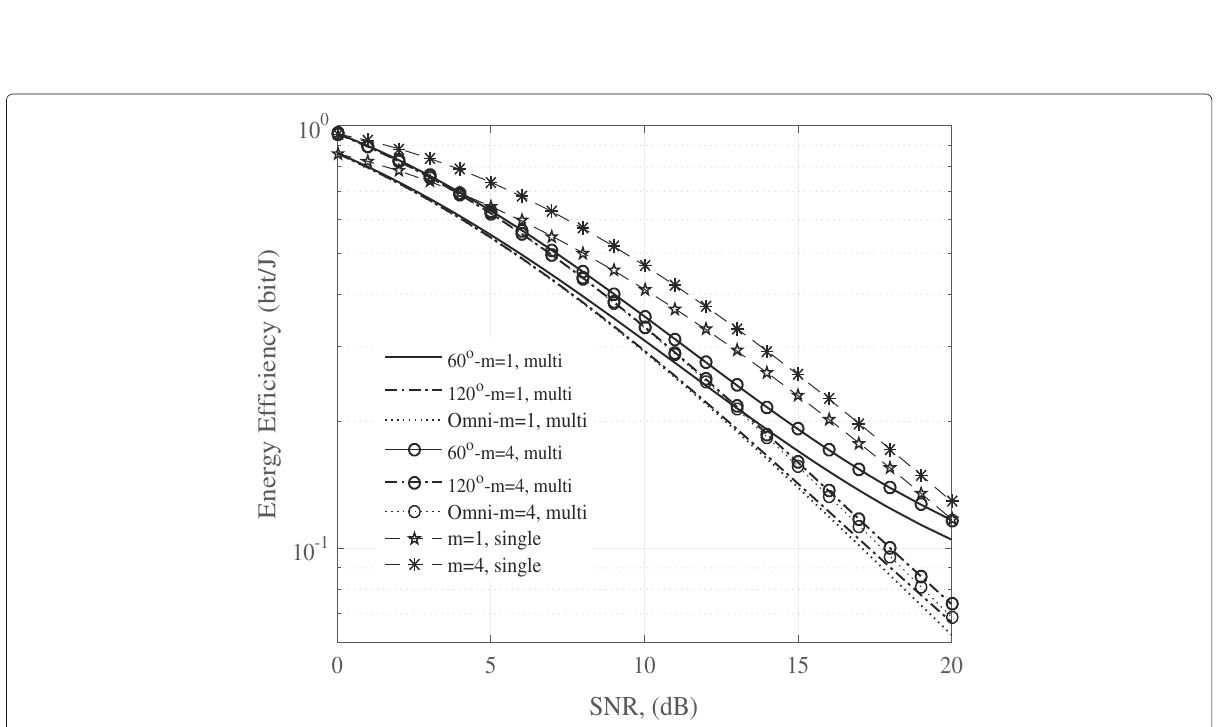
Fig. 5 Energy efficiency in (bit/J) for single- and multi-cell cellular networks for three different antenna configurations as a function of SNR for various values of fading figure, m , with R d = 3.5 and α = 4. EE of multi-cell network with omni antenna system for m = 1 and 4, EE of multi-cell network with 120 ◦ sectorized antenna system for m = 1 and 4, EE of multi-cell network with 60 ◦ sectorized antenna system for m = 1 and 4, EE of single-cell network for m = 1 and